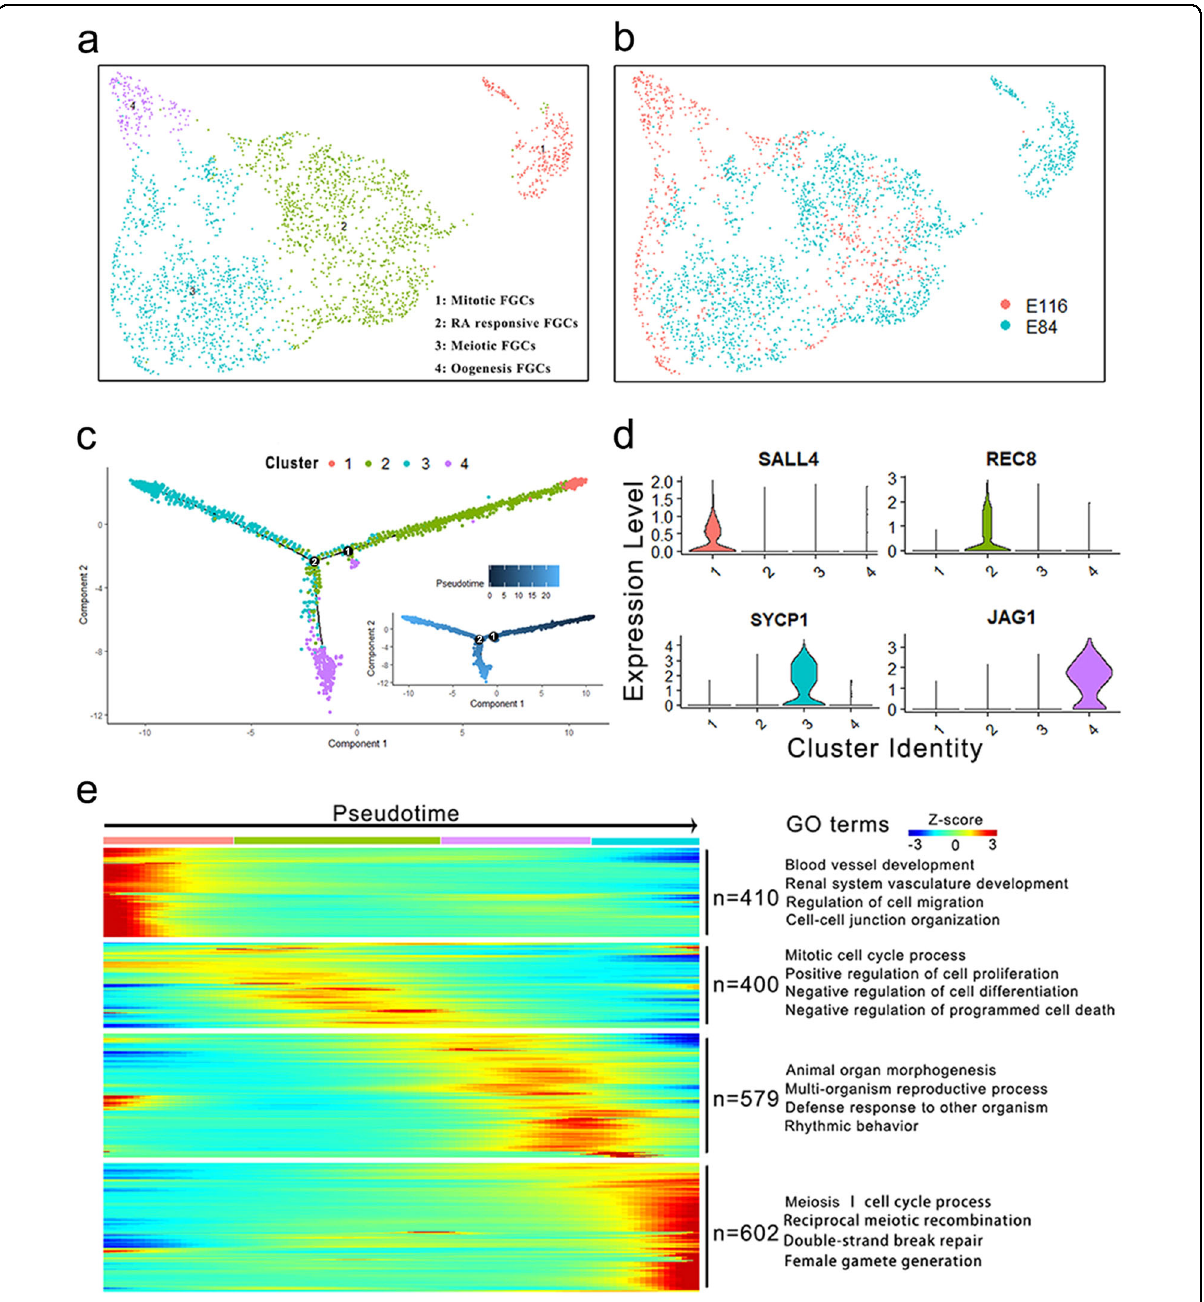
Fig. 2 Cell lineage reconstruction and identi fi cation of the germ cells. a Isolation and re-clustering of the germ cell populations at a higher resolution. The assigned clusters are consistent with that in Fig. 1b. b UMAP plot of single-cell transcriptome data with germ cells colored based on their embryonic stages. c Pseudotime analysis of germ cells. Cluster 1 represents the start of pseudotime, with cluster 4 at the end. d Violin plots show the expression patterns of marker genes during oogenesis. e Hierarchical clustering of the ordering genes during early oogenesis. Each row represents an ordering gene, and each column represents a single germ cell. The GO terms of clustered ordering genes are listed on the